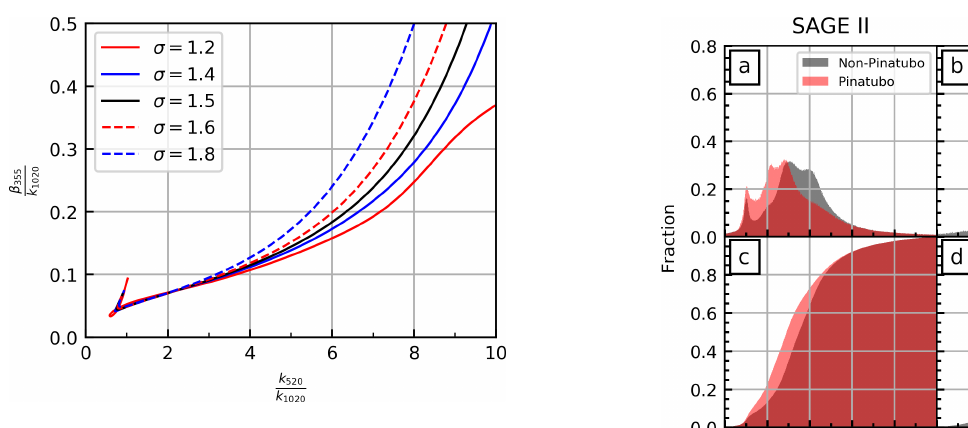
Figure 2. Theoretical relationship between the inverted lidar ratio ( S − 1 ) and extinction ratio. Wavelength selection was based on the ground-based backscatter lidars and available SAGE channels.